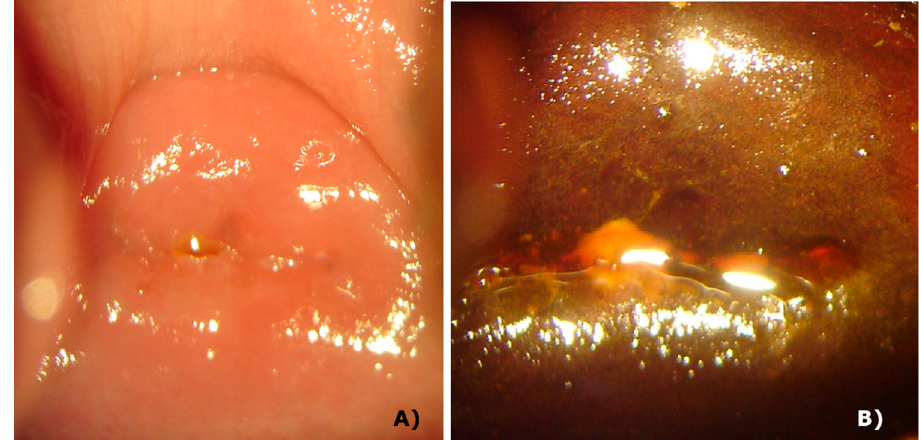
Figure 5. Cervix 2.5 years after PDT. Panel A : white light image, showing the integrity of tissue. Panel B : white light image after colposcopy, with no damage.